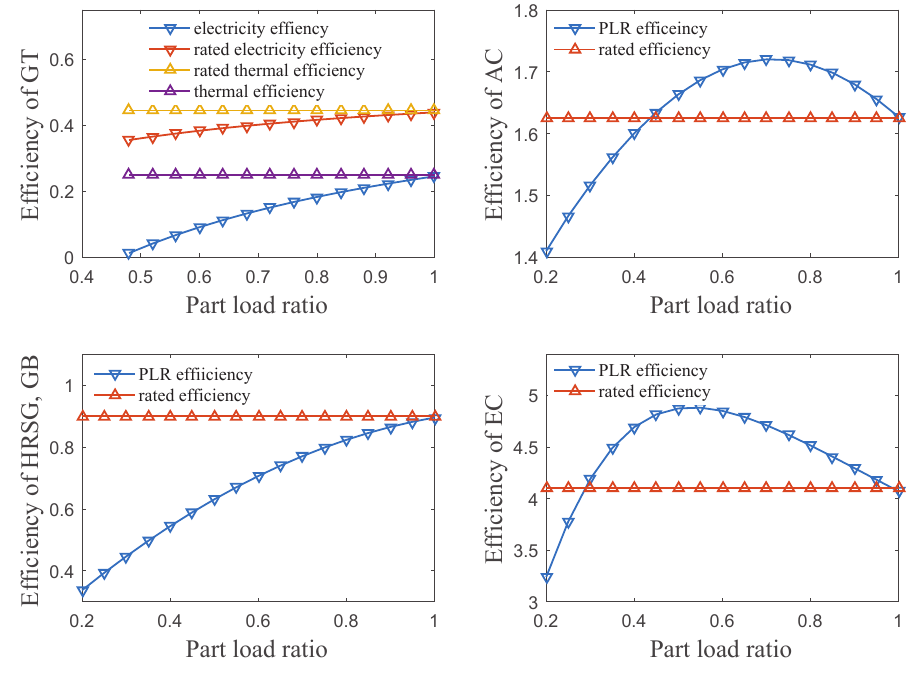
Figure 4. Efficiency curves of GT, AC, EC, GB and HRSG.